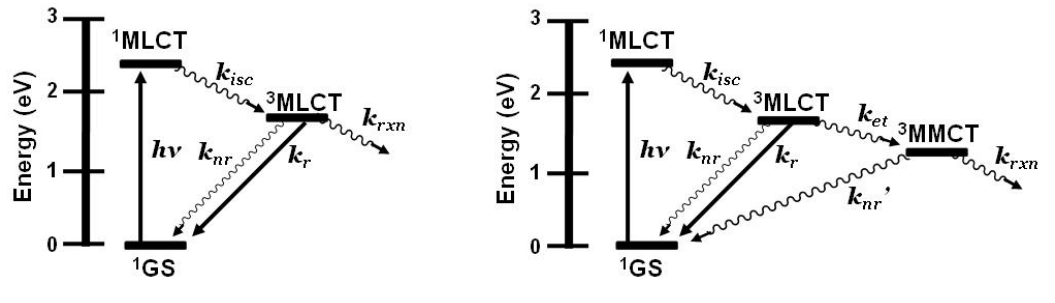
= intersystem crossing rate constant, isc = non-radiative decay rate constant, k = intramolecular nr et = photochemical reaction rate rxn